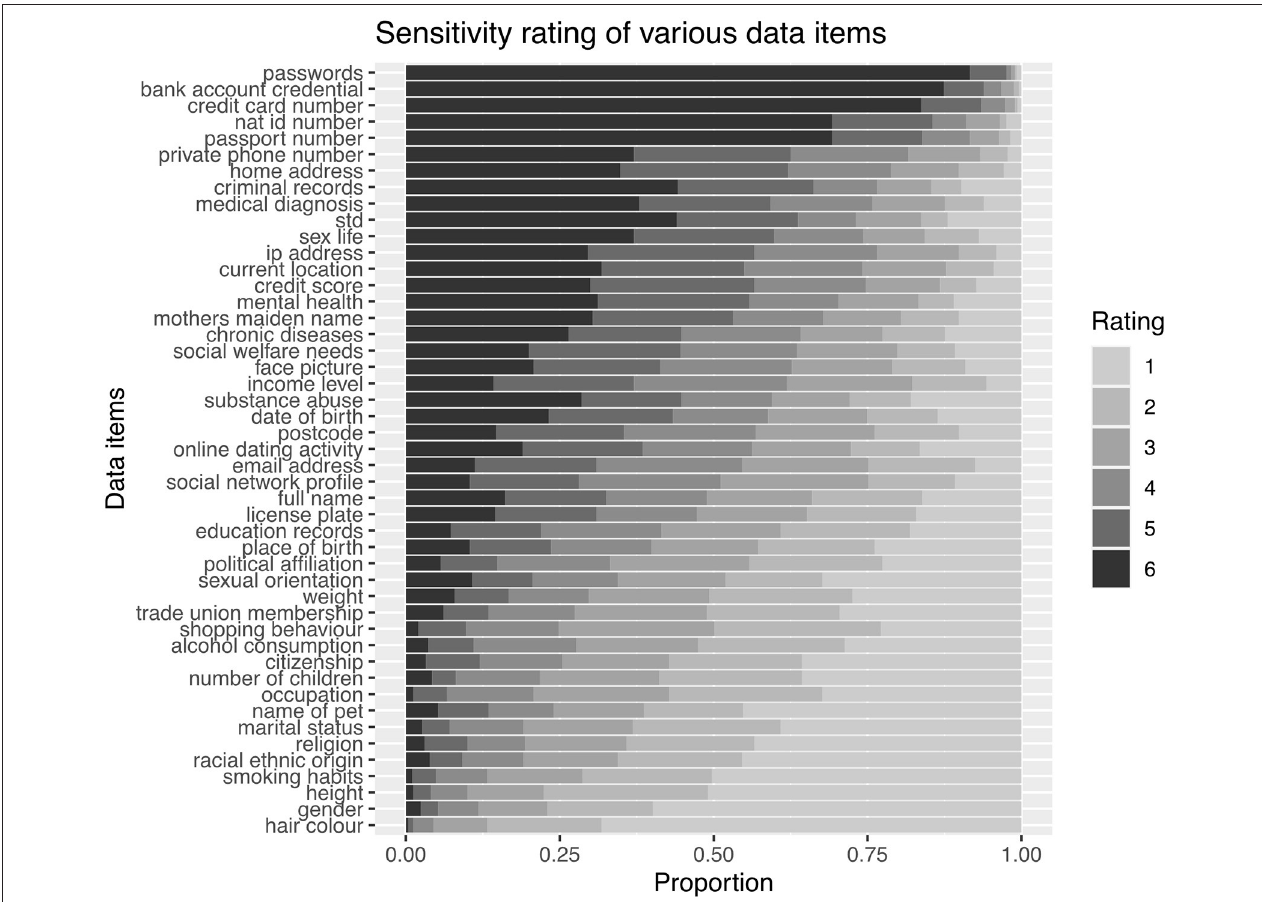
FIGURE 2 | Sensitivity ratings of data